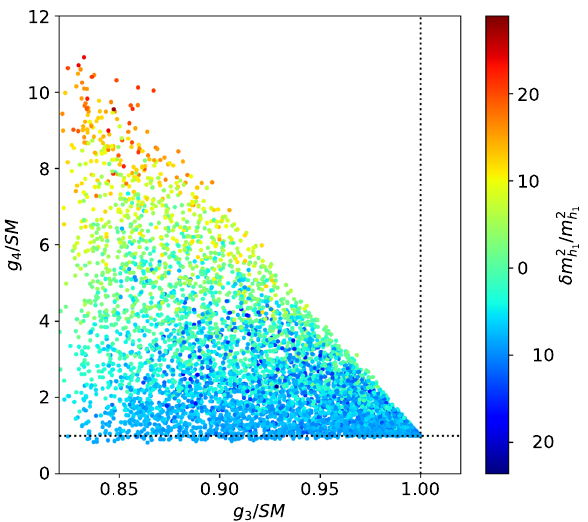
Fig. 5 g 3 / g SM the radiative correction, δ m 2